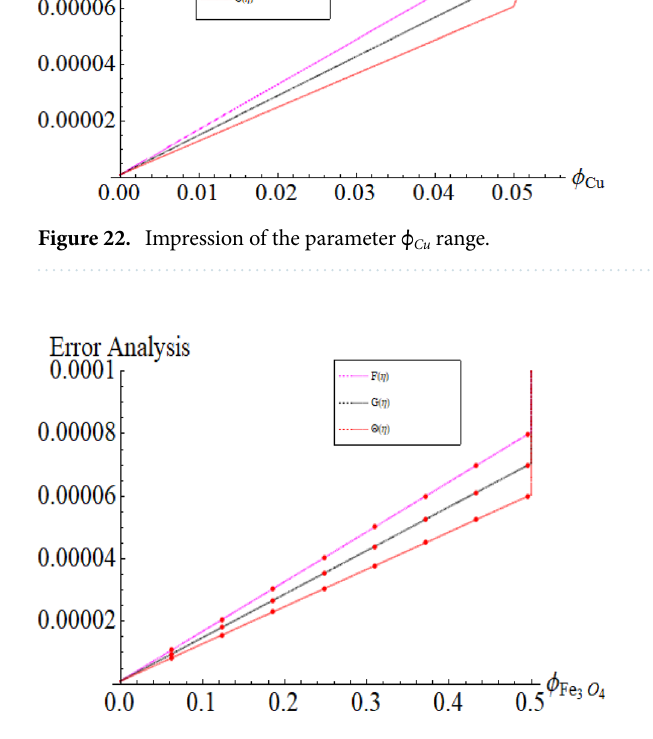
Figure 23. Impression of the parameter φ Fe 3 O 4 range.